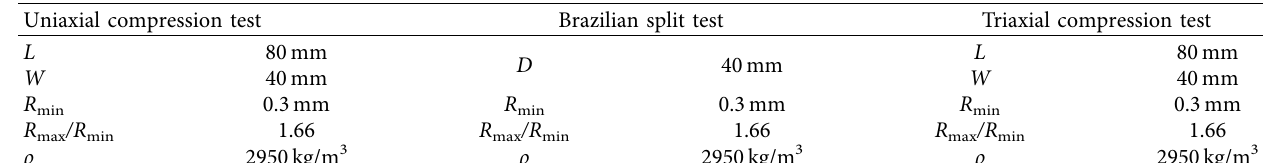
Table 3: Model size information.